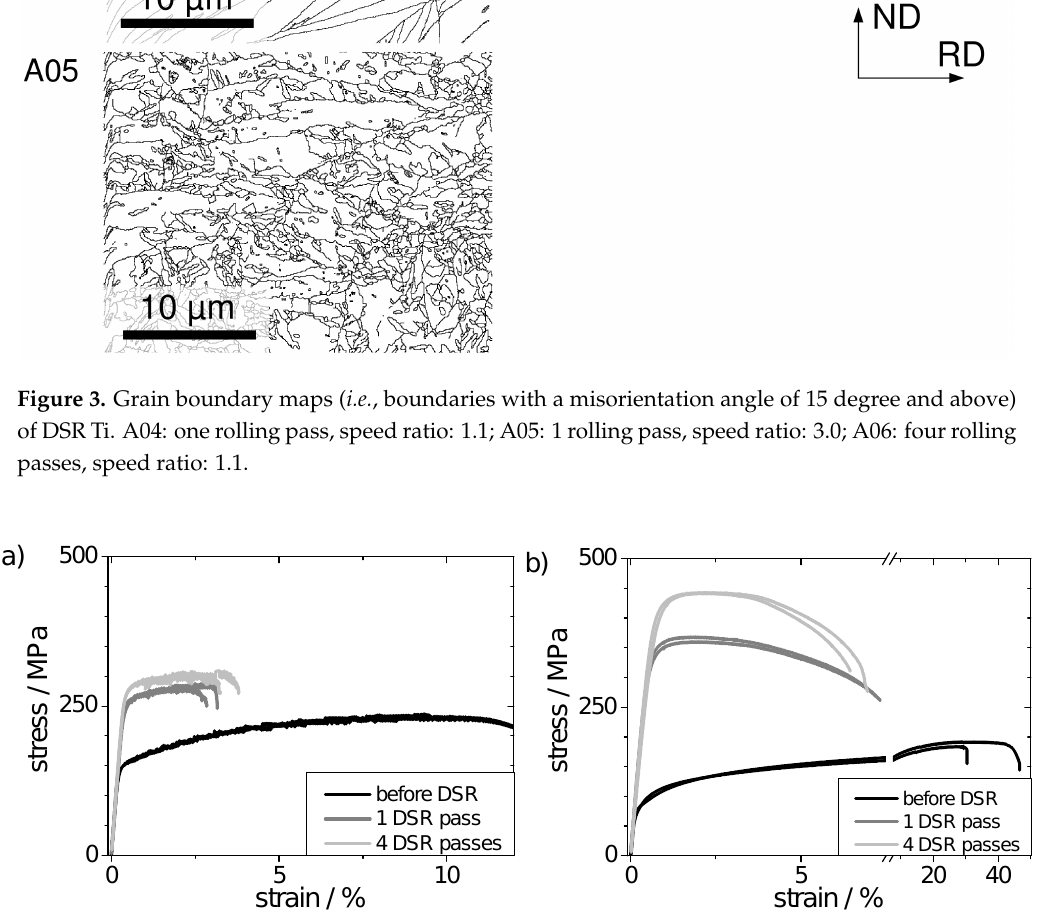
Figure 4. Engineering stress-strain curves for ( a ) Al and ( b ) Ti sheets in the cold rolled condition and after one and four DSR passes at a speed ratio of 1:1. Results for two samples in each condition are shown in order to illustrate the occurring